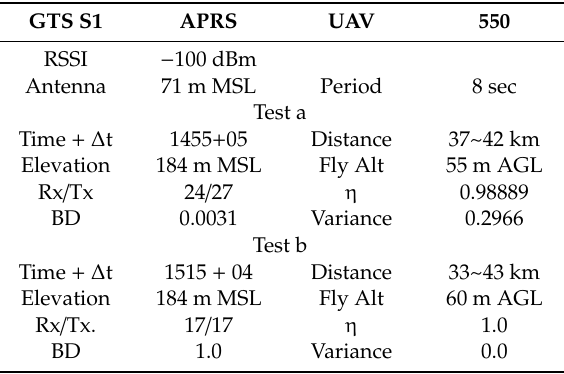
Table 7. Test data at CJCU (S1) on APRS GTS.